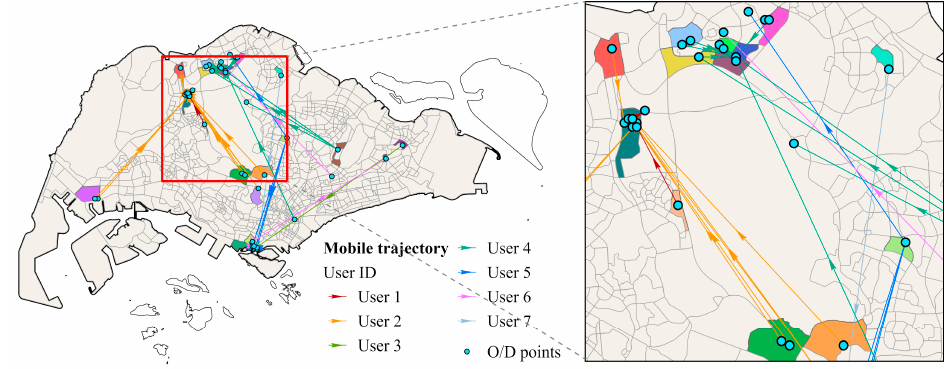
Figure 12. Sampled mobile trajectories in Singapore. Based on the identified UFZ categories, we analyzed the mobility patterns within different UFZs. Figure 13 shows the flow of taxis from an origin UFZ to a destination UFZ. The movements between public service, commercial, and residential zones account for over 80% of total trajectories in Zhuhai among which the public service zone contributes to most taxi trajectories. In the Singapore trajectory dataset, the movements between residential zones account for a considerable proportion of total trajectories (Figure 14). The flow between the different UFZs indicates that after leaving a residential zone, people are more likely to travel to another residential zone, and the second highest possibility is to a green space zone. For most people leaving commercial zones, public service zones, green space zones or industrial zones, the highest possibility is to travel back to residential zones.